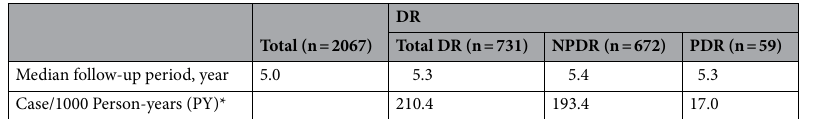
Table 2. Incidence rate of DR. DR diabetic retinopathy; NPDR isolated non-proliferative diabetic retinopathy; PDR proliferative diabetic retinopathy. *PY: Person year, By Miettinen’s (1974d) modification, as described in Epidemiologic Analysis with a Programmable Calculator, 1979. Results from OpenEpi, Version 3, open source